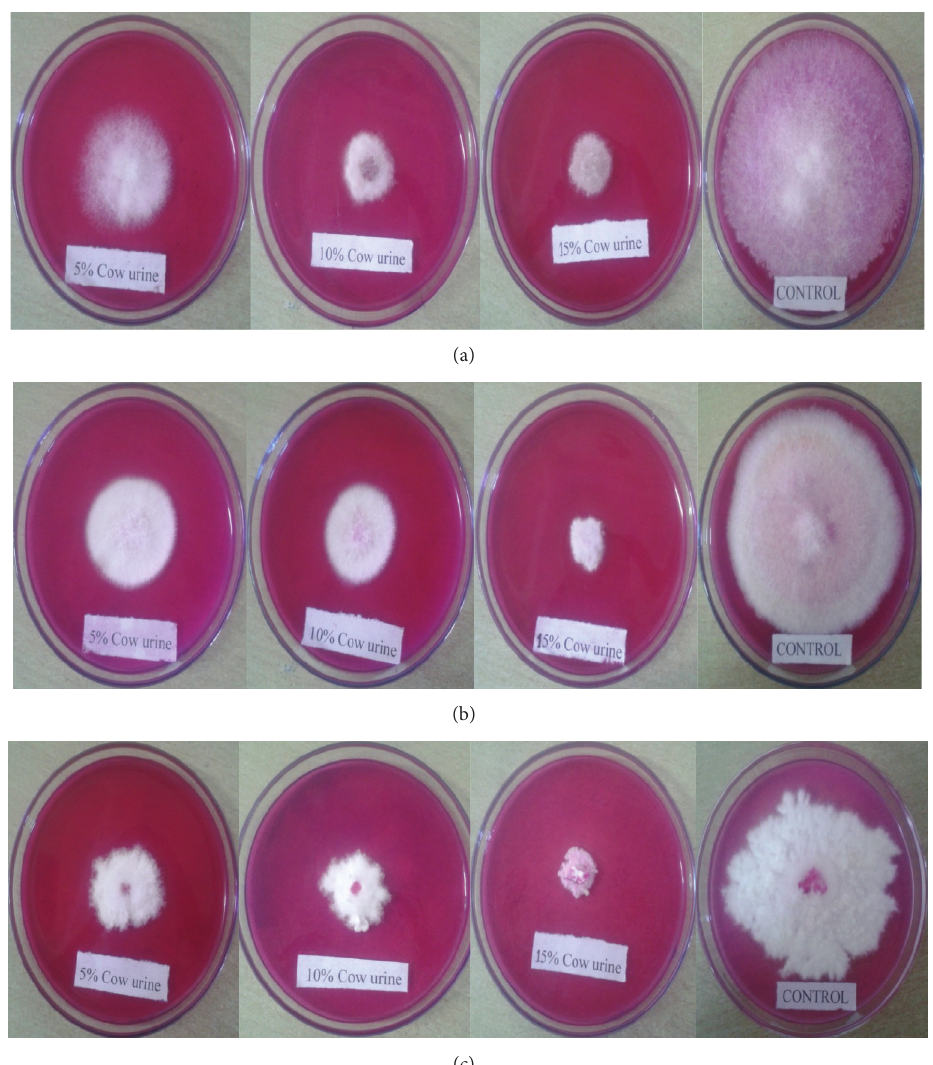
Figure 1: (a) Effect of different concentrations (5%, 10%, and 15%) of cow urine on Fusarium oxysporum . (b) Effect of different concentrations (5%, 10%, and 15%) of cow urine on Rhizoctonia solani . (c) Effect of different concentrations (5%, 10%, and 15%) of cow urine on Sclerotium rolfsii .